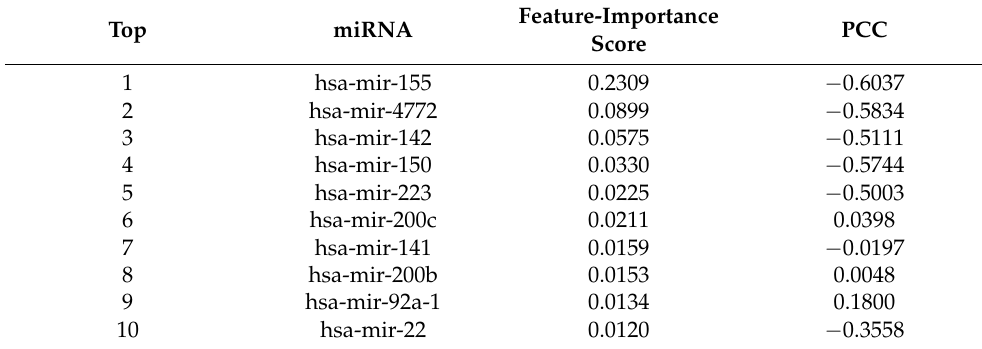
Table 3. Top 10 miRNAs by feature importance and Pearson correlation coefficient (PCC). Top